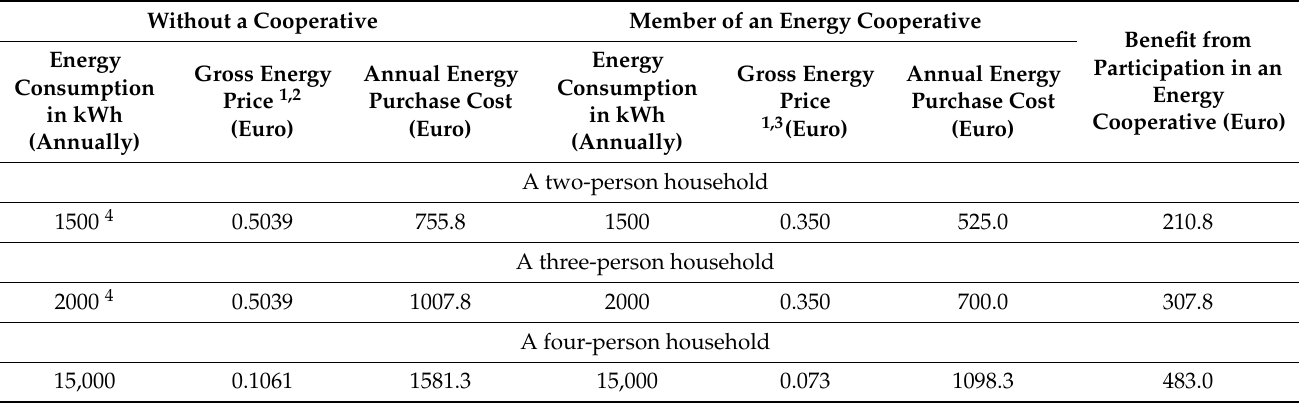
Table 1. Simulation of the potential benefits of participating in a household energy cooperative (in Euro)